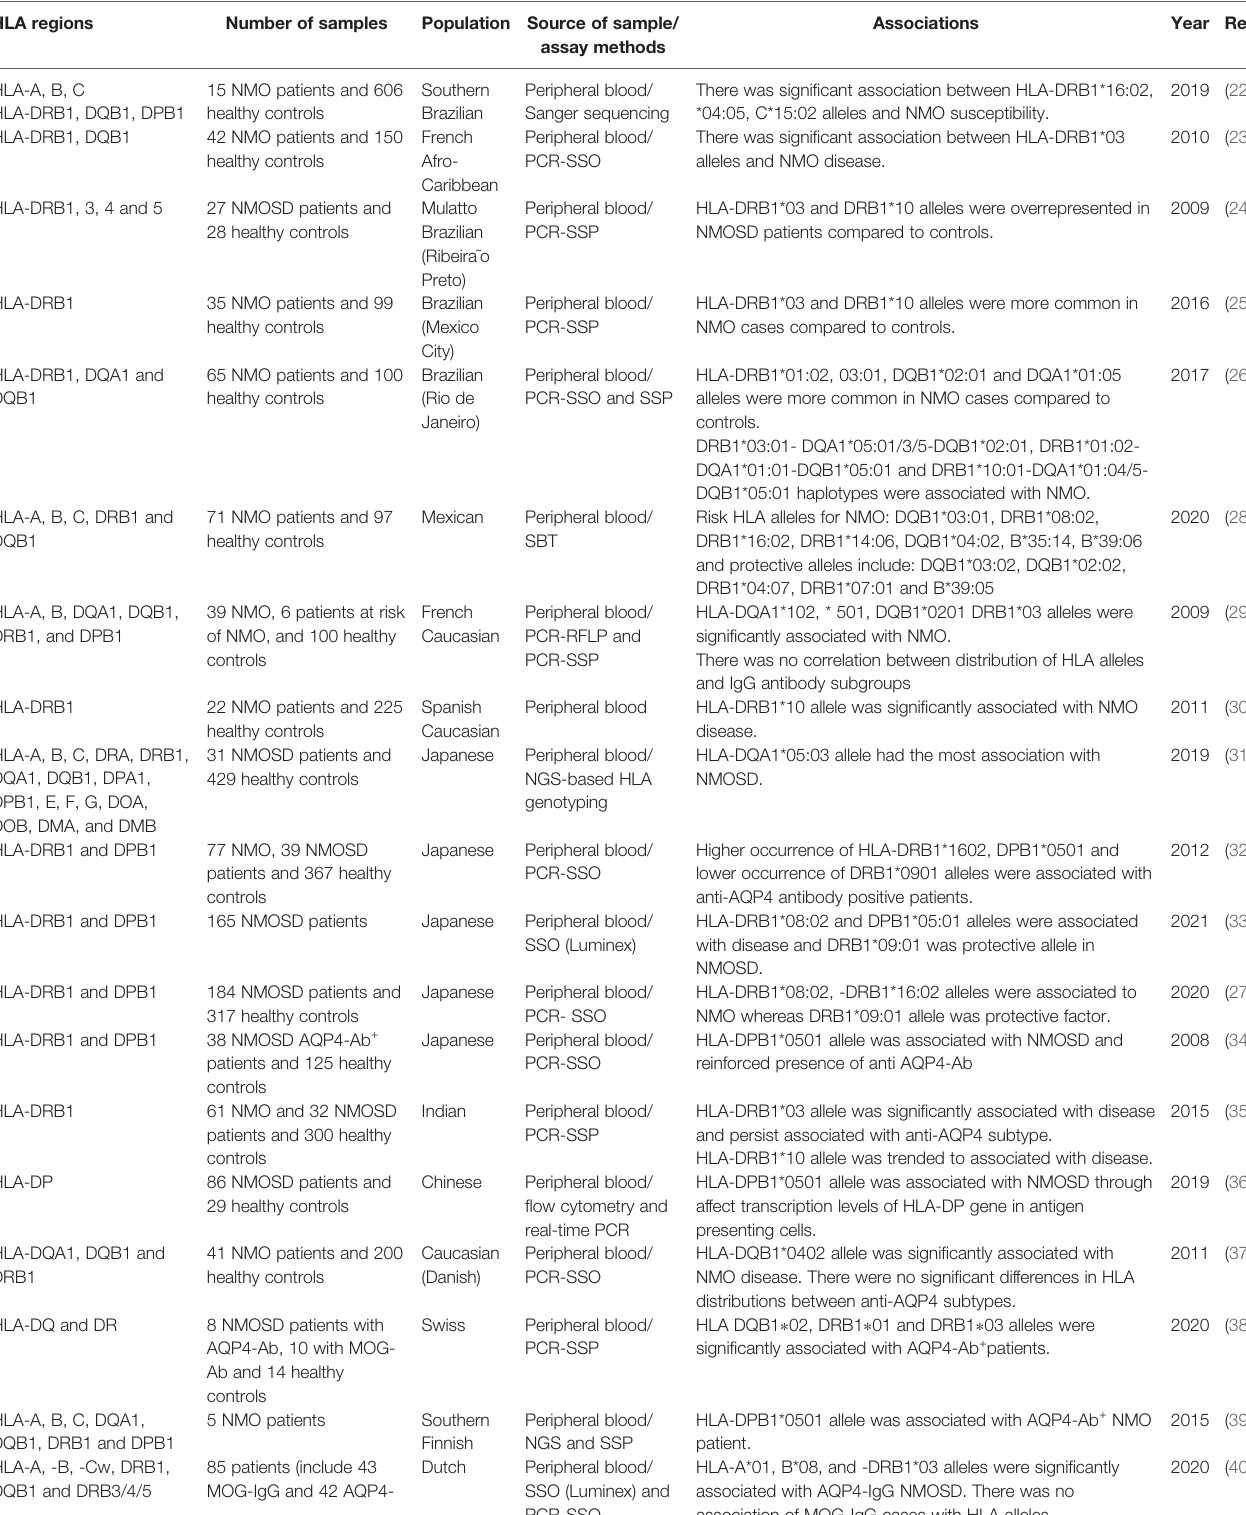
TABLE 2 | HLA studies in neuromyelitis optica (SSP-PCR, sequence-speci fi c primers – polymerase chain reaction; PCR-SSO, polymerase chain reaction – sequence speci fi c oligoprobes; SBT, sequencing-based typing; MOG-Ab, myelin oligodendrocyte glycoprotein